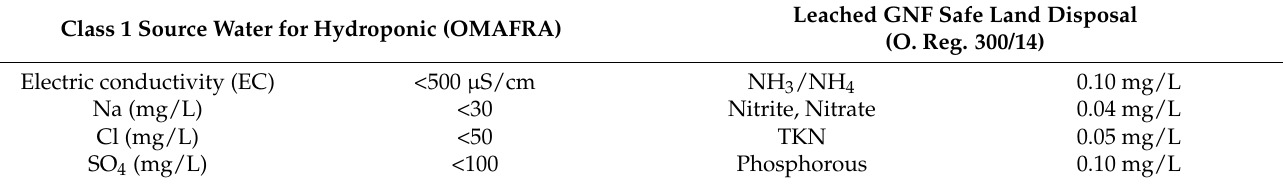
Table 7. GNF hydroponic source water and disposal quality.